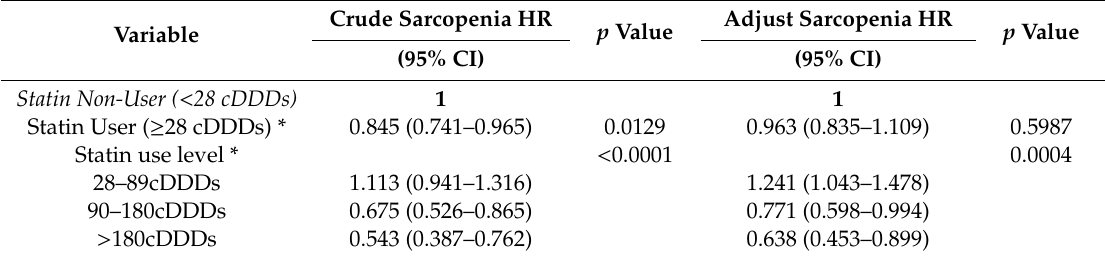
Table 4. Association between statin and first-time sarcopenia among CKD patients in Taiwan with time- dependent covariates for statin.